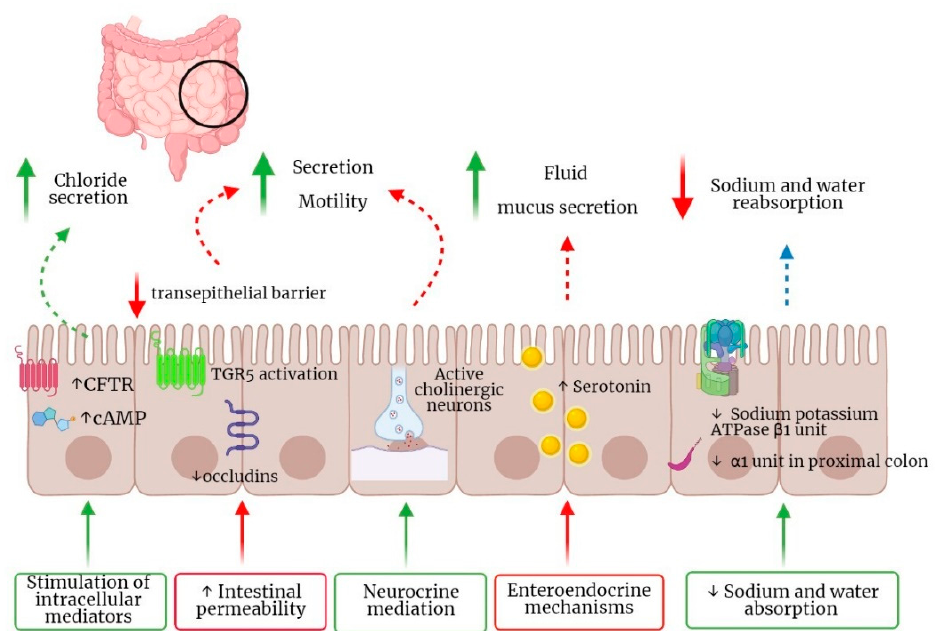
Figure 2. Pathophysiology of diarrhea in bile acid malabsorption. Abbreviations: CFTR: Cystic fibrosis transmembrane conductance regulator; cAMP: cyclic adenosine monophosphate; TGR5: Takeda G protein-coupled receptor 5; ATPase: Adenosine triphosphate-hydrolyzing enzymes.